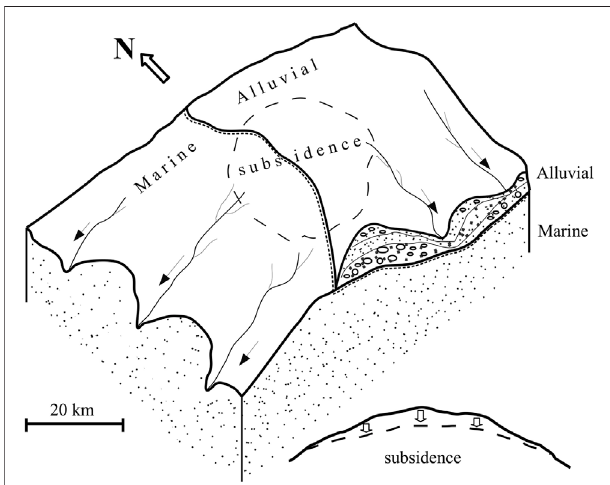
FIGURE 13 | 3D scheme ofC zone with different lithology depending on the hydrographic system. The subsiding area at the topographic height. NS runoff in alluvial may be triggered sedimentary structures in marine segment. EW runoff controlled by inherited currents of the nearshore unconsolidated deposits.